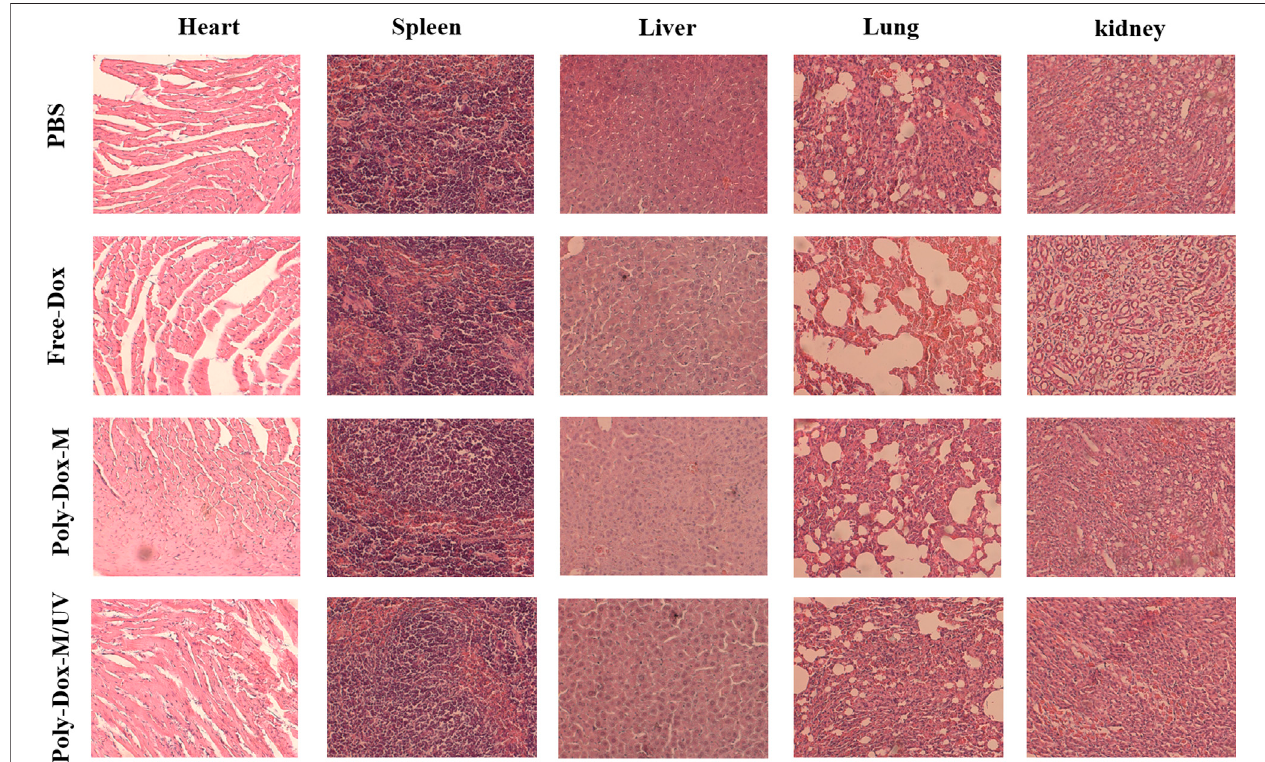
FIGURE 6 | H&E staining of various tissues including heart, liver, spleen, lung and kidney extracted from the mice treated with PBS, Free-Dox, Poly-Dox-M under UV irradiation or not.